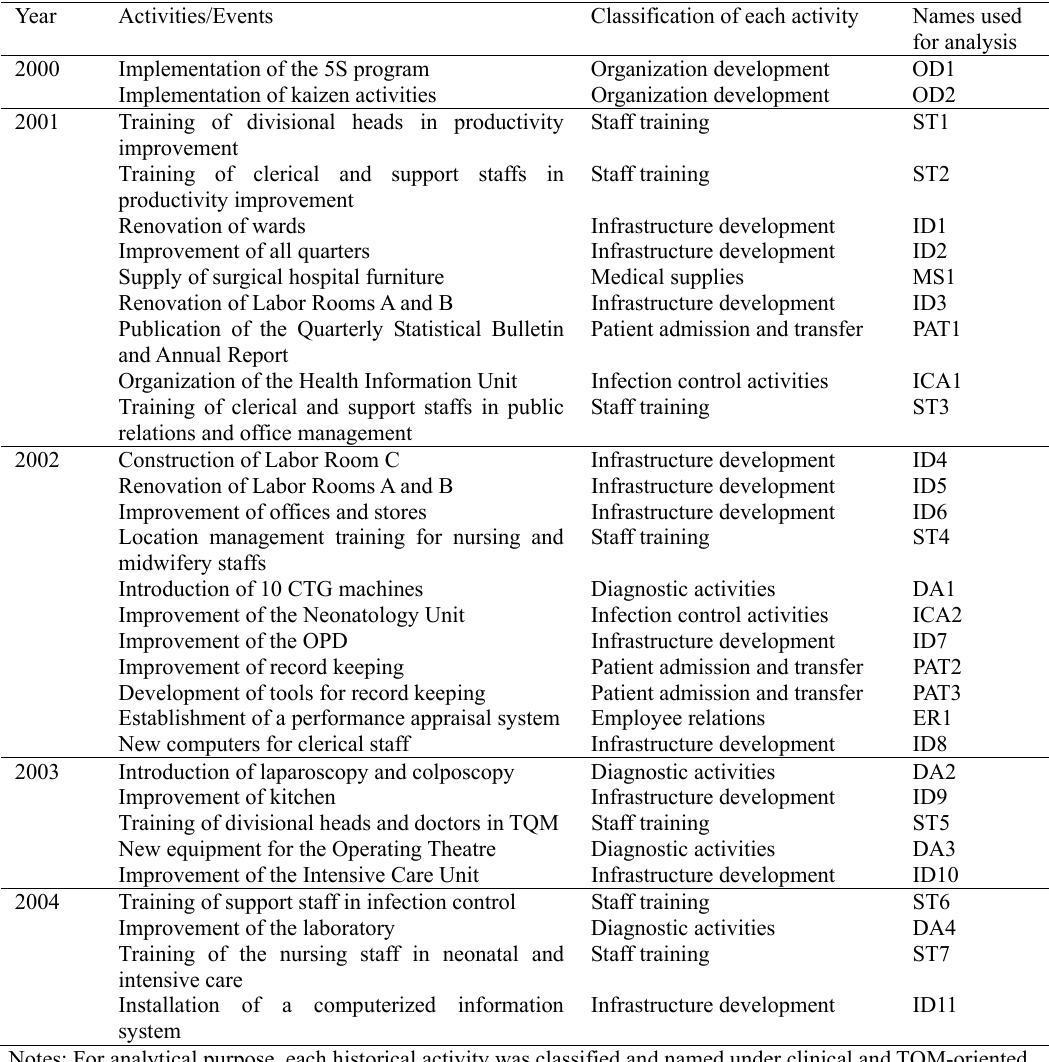
Table 1. Timeline of the TQM implementation process at